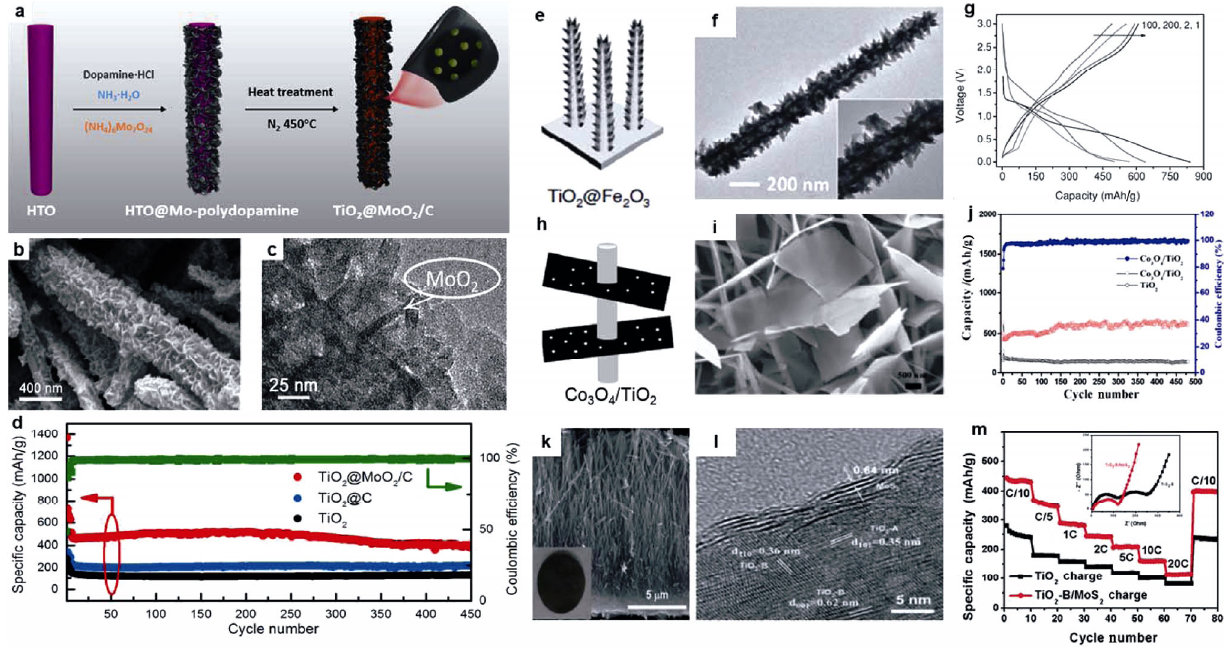
Fig. 5 Recent progress of TiO 2 hybrid nanocomposites with conversion-type anodes. (a) Schematic of the synthetic process, (b) SEM image, (c) HRTEM image, and (d) cycling performance (at 500 mA/g) of TiO 2 @MoO 2 /C nanocomposite. Reproduced with permission from Ref. [57], © American Chemical Society 2017. (e) Schematic model, (f) TEM image, and (g) galvanostatic discharge/charge profiles (at 200 mA/g) of TiO 2 @Fe 2 O 3 nanocomposites. Reproduced with permission from Ref. [58], © John Wiley and Sons 2013. (h) Schematic model, (i) SEM image, and (j) cycling performance (at 200 mA/g) of the Co 3 O 4 /TiO 2 heterostructures. Reproduced with permission from Ref. [59], © Springer Nature 2012. (k) SEM image, (l) HRTEM image, and (m) rate performances of TiO 2 -B/MoS 2 nanowires. Reproduced with permission from Ref. [60], © The Royal Society of Chemistry